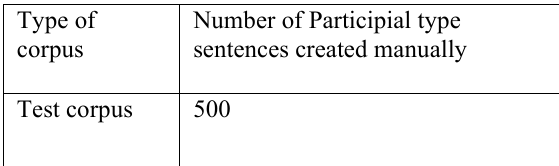
Table 6. Manually created test data